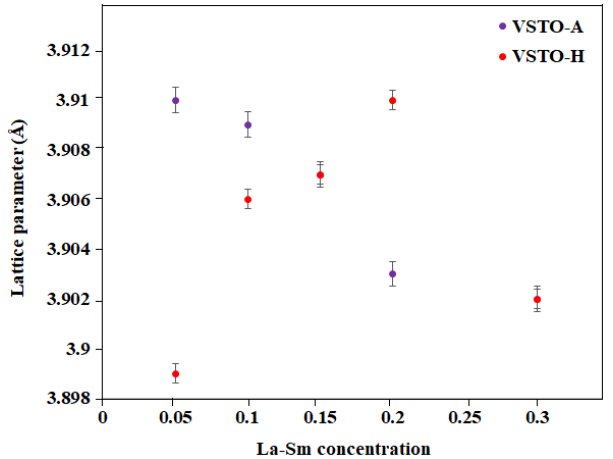
Figure 2. Dopant (La + Sm) concentration dependence of lattice parameters for VSTO-A and VSTO- H ceramics.